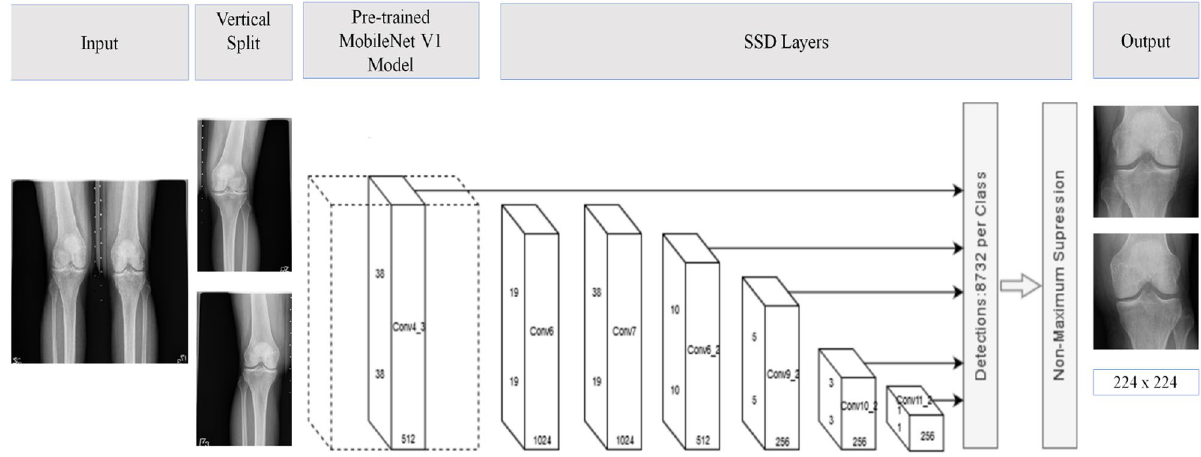
Figure 6. The network architecture for knee localization